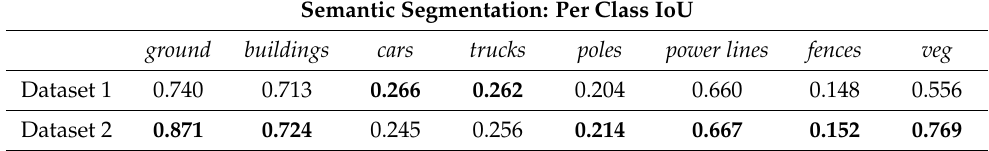
Table 6. Comparison of per class IoU, semantic segmentation results using the PointNet++ archi- tecture. Dataset 1 refers to the DALES Viewpoints Version 2 dataset using only the input points containing occlusions. Dataset 2 refers to the DALES Viewpoint Version 2, which includes the input points with occlusions, supplemented by our generated points.